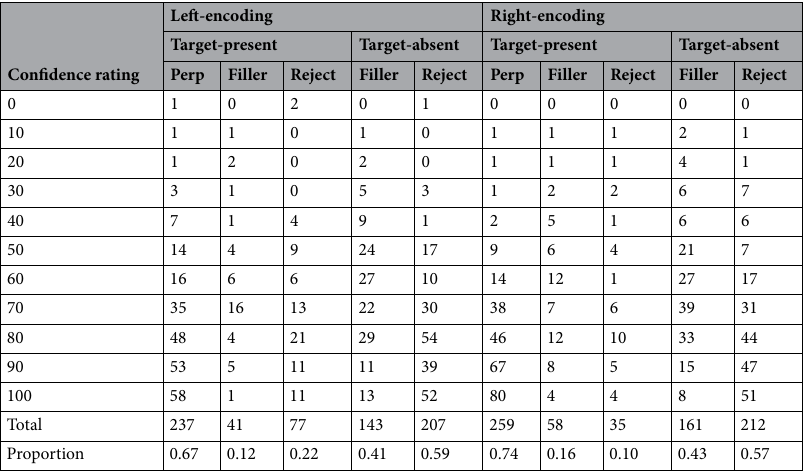
Table 3. Frequencies of perpetrator, filler and reject identification decisions in interactive lineups by encoding condition in Experiment